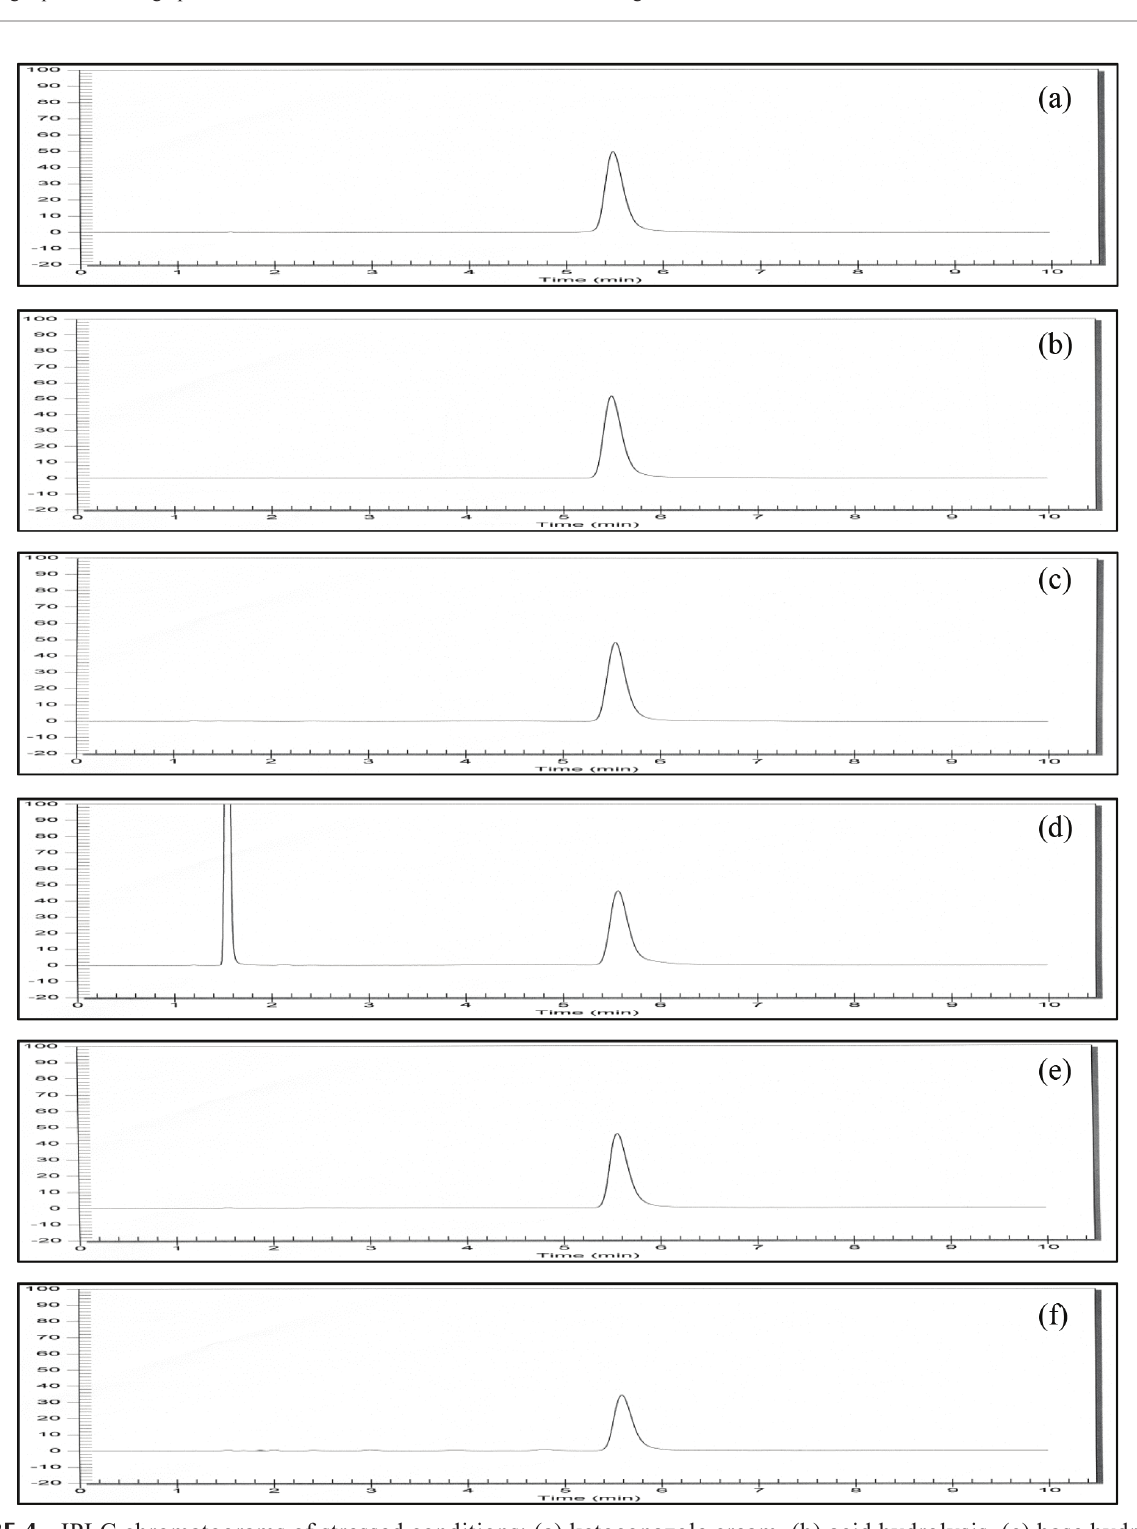
FIGURE 4 - IPLC chromatograms of stressed conditions; (a) ketoconazole cream, (b) acid hydrolysis, (c) base hydrolysis, (d) oxidation, (e) thermal and (f)